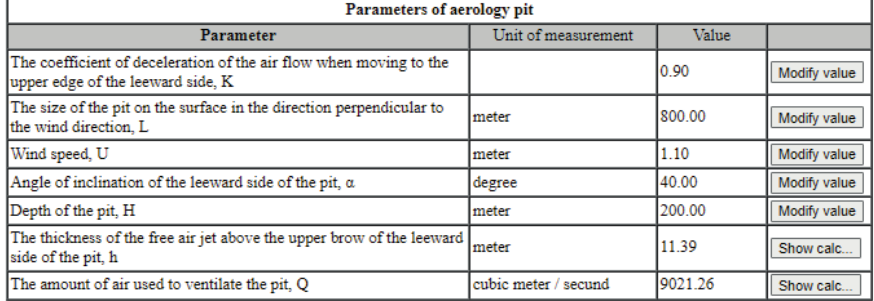
Fig. 4. Parameters of aerology